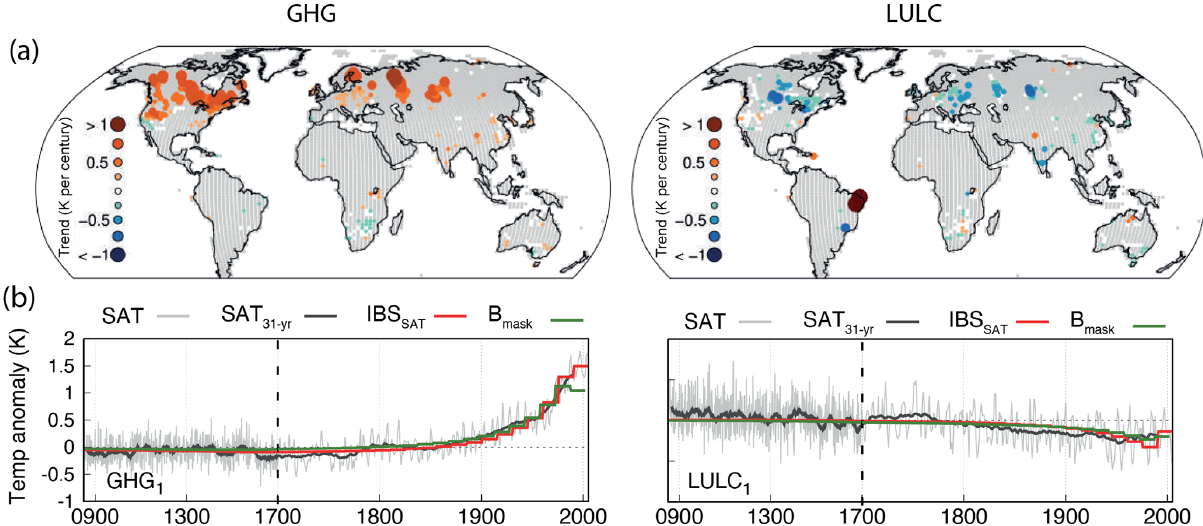
Figure 7. (a) Spatial distribution of linear trends in SAT − GST anomalies over the 1850–2005CE period evaluated at every grid point colocated with a borehole site in the GHG- and LULC-only ensemble mean (left and right in a , respectively). Only grid points delivering statistically significant trends ( p < 0 . 05) are colored. (b) LM global SAT annual anomalies and the corresponding 31-year filtered outputs and the global IBS SAT and the B mask pseudo-reconstructions for the GHG 1 and LULC 1 ensemble members. Note the different discretization in the x axis after